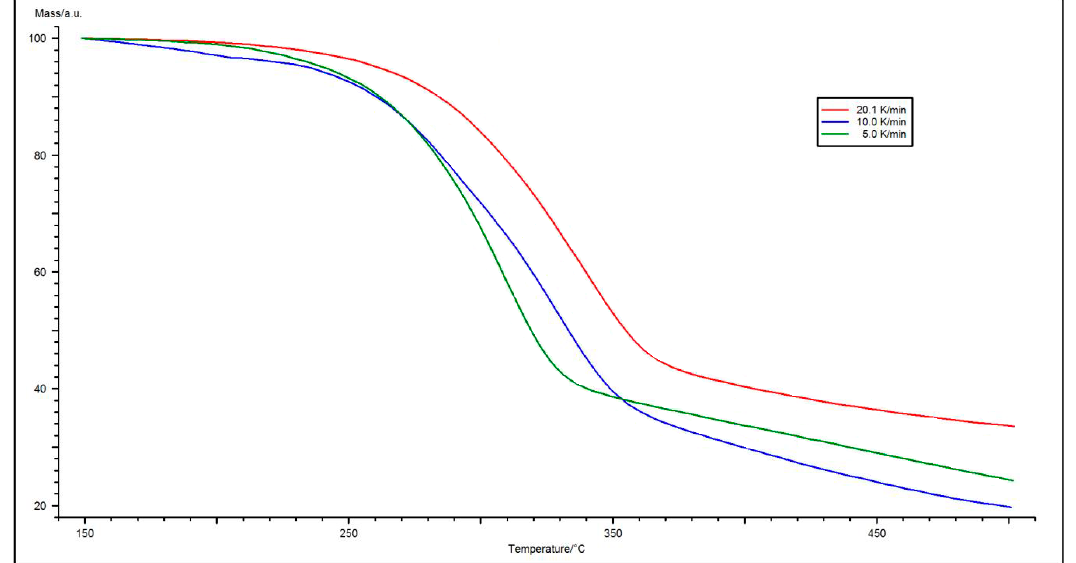
Figure 4. TG curves for three heating rates recorded for a oat straw sample.